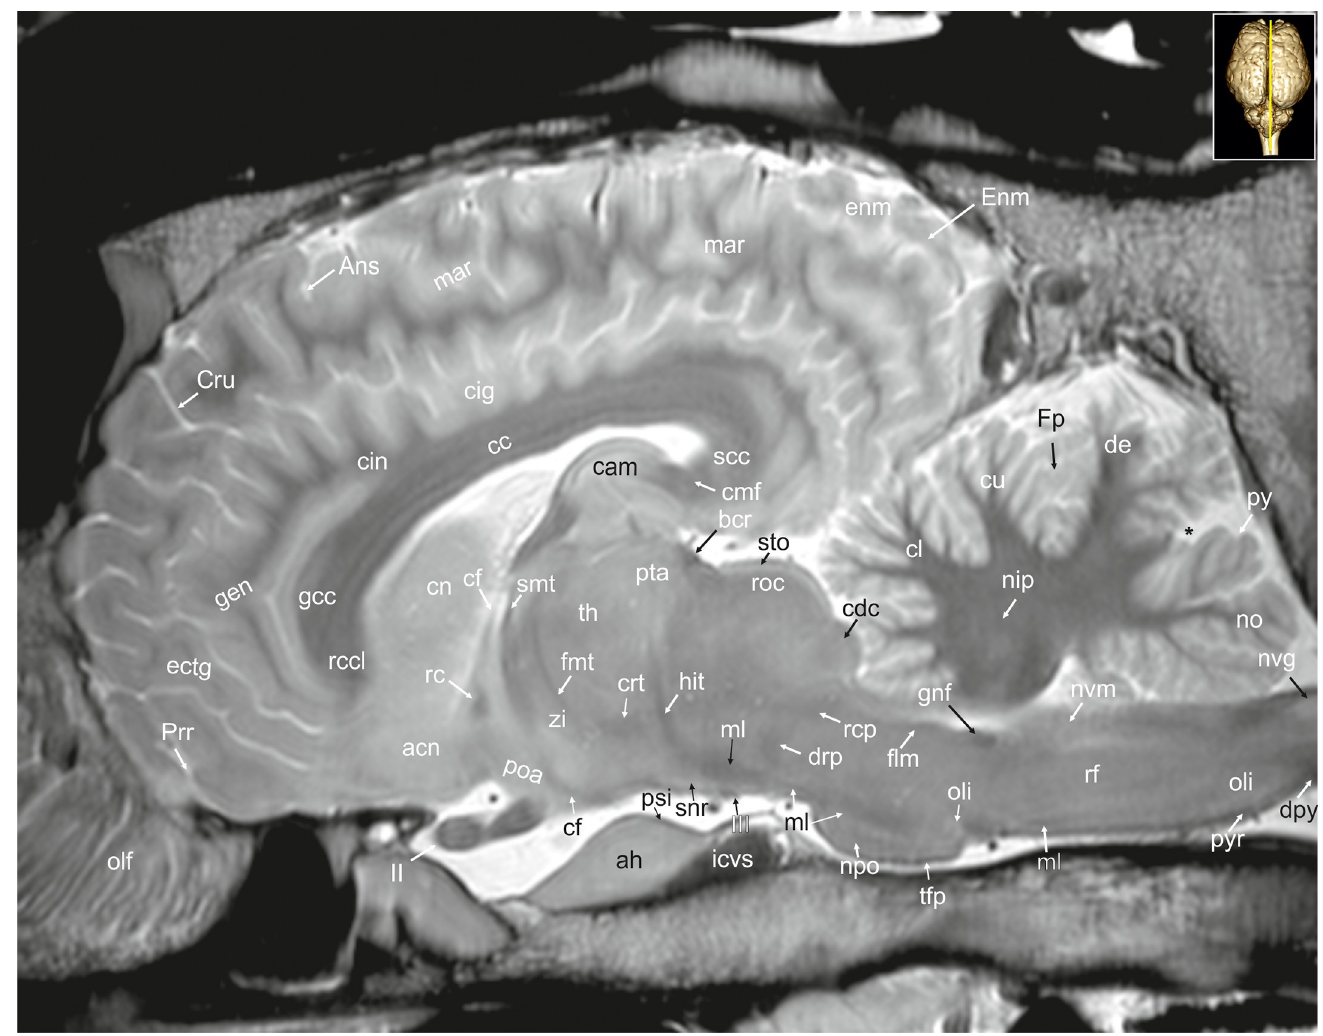
Fig 28. Parasagittal magnetic resonance image of the equine brain on the level of the habenulo-interpeduncular tract. acn: accumbens nucleus, ah: adenohypophysis, Ans: ansate sulcus, bcr: brachium of the rostral colliculus, cam: ammon’s horn, cc: corpus calosum, cdc: caudal colliculus, cf: column of fornix, cig: cingulate gyrus, cin: cingulum, cl: central lobule, cmf: commissure of fornix, cn: caudate nucleus, crt: rubro-cerebello-thalamic tract, Cru: cruciate sulcus, cu: culmen, de: declive of the vermis, dpy: pyramidal decussation, drp: decussation of the rostral cerebellar peduncles, ectg: ectogenual gyrus, enm: endomarginal gyrus, Enm: endomarginal sulcus, flm: medial longitudinal fasciculus, fmt: mammilo-thalamical fasciculus, Fp: primary fissure, gcc: genu of the corpus callosum, gen: genual gyrus, gnf: genu of the facial nerve, hit: habenulo-interpeduncular tract, icvs: intercavernous sinus, mar: marginal gyrus, ml: medial lemniscus, nip: interpositus nucleus, no: nodulus of the vermis, npo: nuclei of the pons, nvg: nucleus of the vagal nerve, nvm: medial vestibular nucleus, olf: olfactory fibres, oli: olivary nucleus, opn: optic nerve, poa: preoptic area, Prr: prorean sulcus, psi: pars intermedia of the pituitary gland, pta: pretectal area, py: pyramis of the vermis, pyr: pyramidal tract, rc: rostral commissure, rccl: rostrum of corpus callosum, rcp: rostral cerebellar peduncle, rf: reticular formation, roc: rostral colliculus, scc: splenium of corpus callosum, smt: medullary stria of the thalamus, snr: substantia nigra, sto: stratum opticum of the rostral colliculus, tfp: transvers fibres of pons, th: thalamus, zi: zona incerta, III: oculomotor nerve. asterisk: blind ending medullary branches, uncovered with cortex.